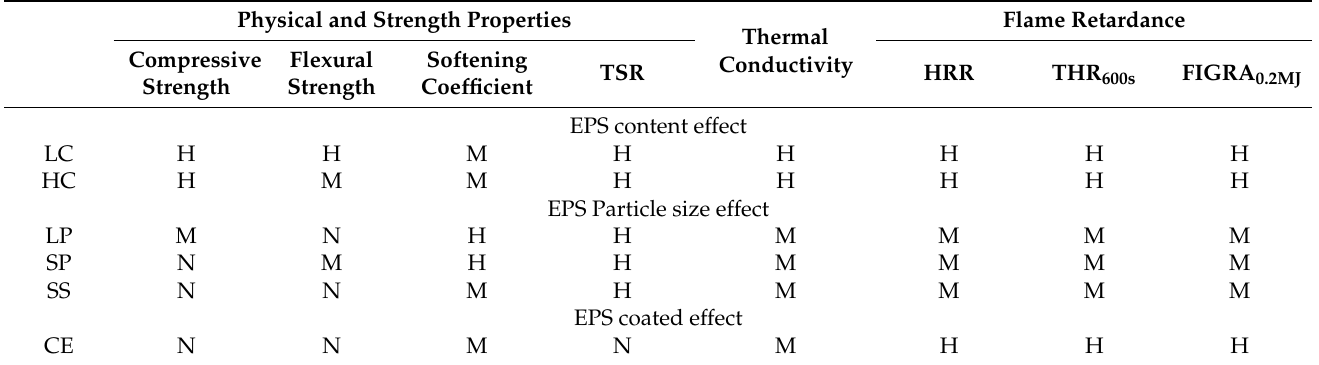
Table 2. A significant analysis of strength, thermal conductivity, and flame retardance of CEPS.